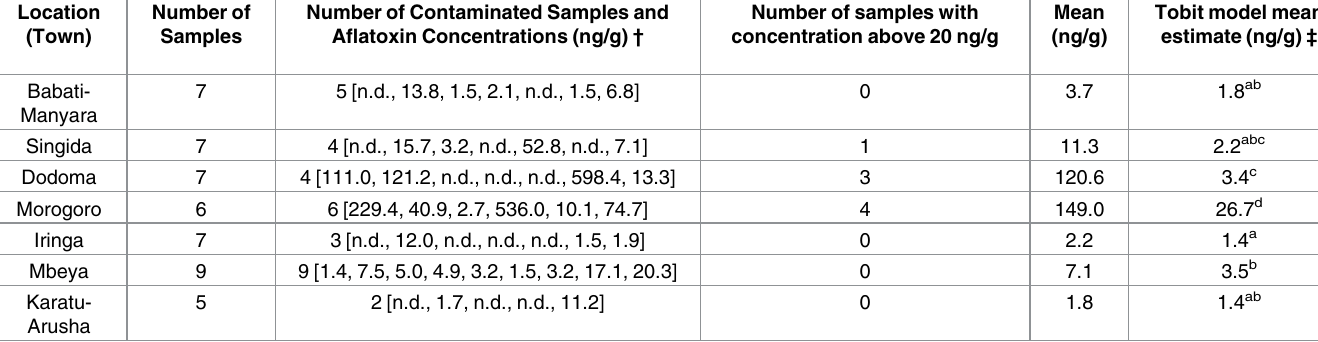
Table 5. Aflatoxin concentrations in sunflower seed cakescollected from micro- and small-scale sunflower oil processors in Tanzania in the sun- flower-harvesting season of 2015. Location